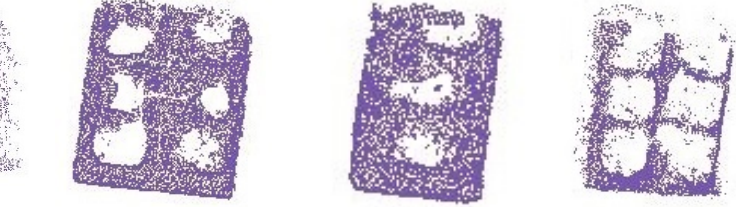
Figure 9. Employing intensity in removing the voyeur effect. ( a ) The intensity histogram, ( b ) highlighted intensities on the point cloud, and magnification of the voyeur effect.